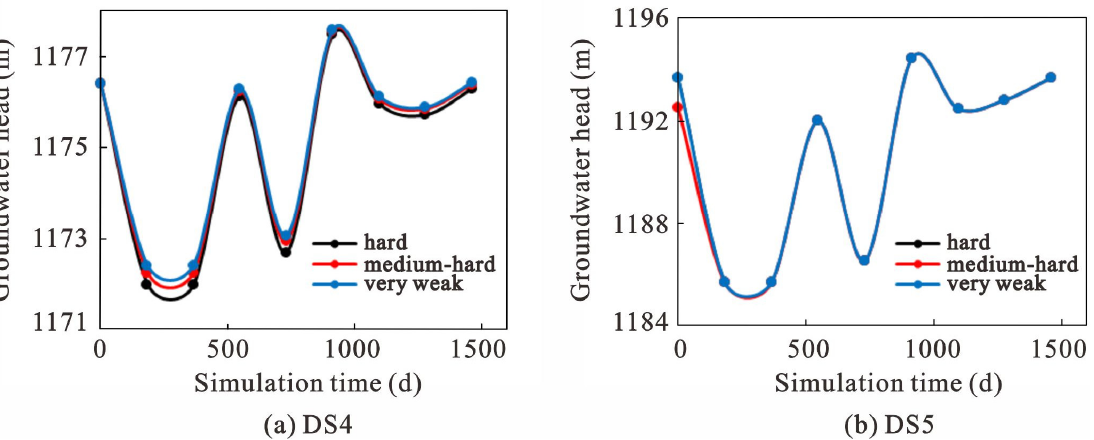
Figure 13. Variation in groundwater level in the lower aquifer system under different lithologies of overlaying strata: ( a ) DS4, ( b ) DS5. Note: As the water level change is not obvious, these graphs are zoomed in.